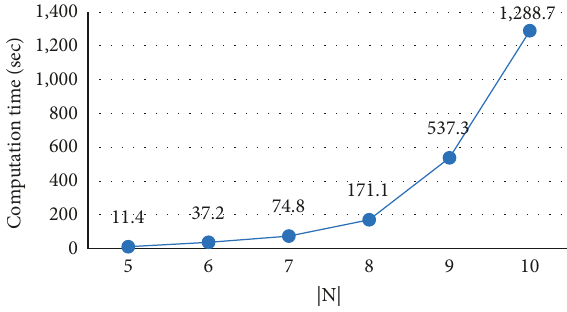
Figure 4: Computation time needed for 10 iterations. Table 2: Key performance indicators using different benchmark